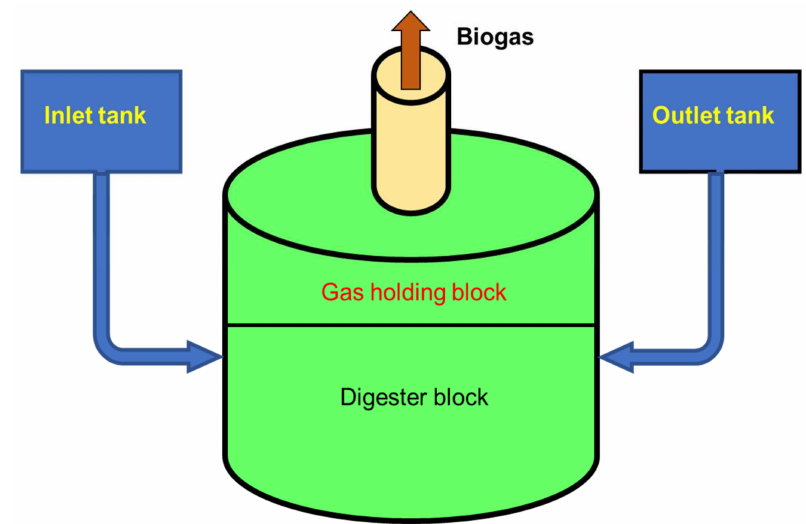
Figure 1. Biomethane